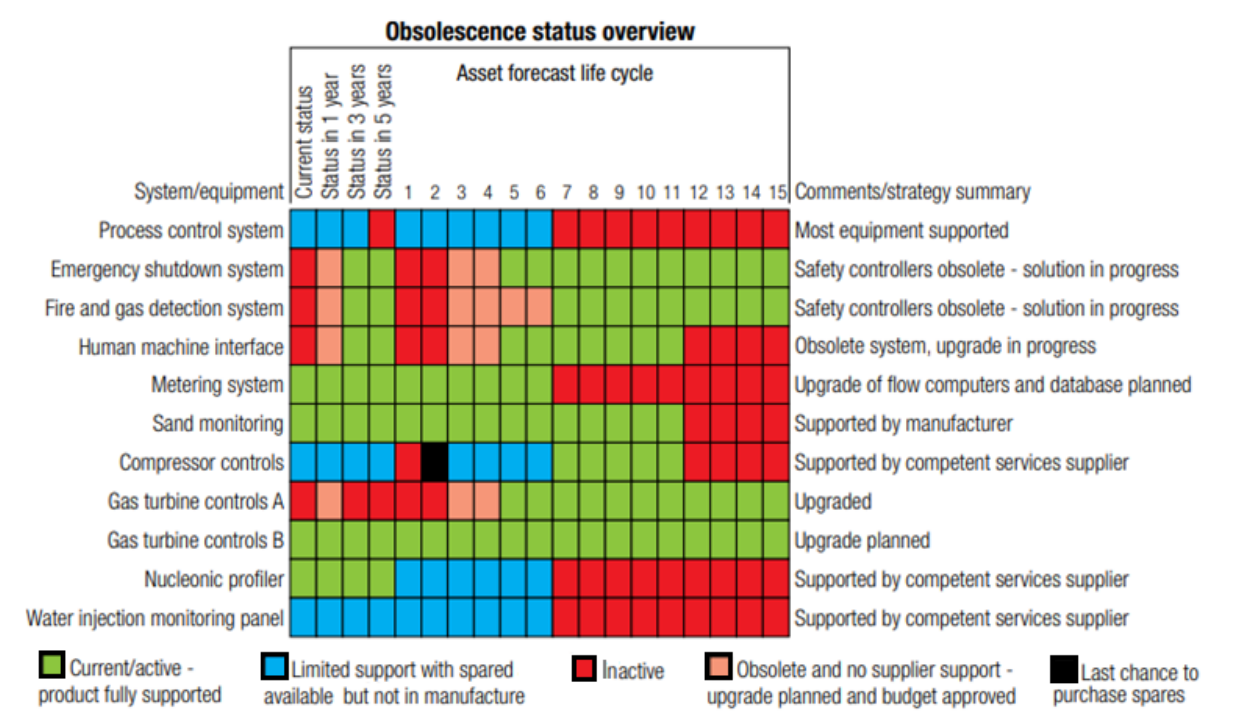
Figure 8. Example of an obsolescence status overview chart, showing different aspects for the lifecycle of an offshore asset (This image was adapted with permission of the Health and Safety Executive under the terms of the Open Government License, Courtesy: HSE, UK. Source: [189]).